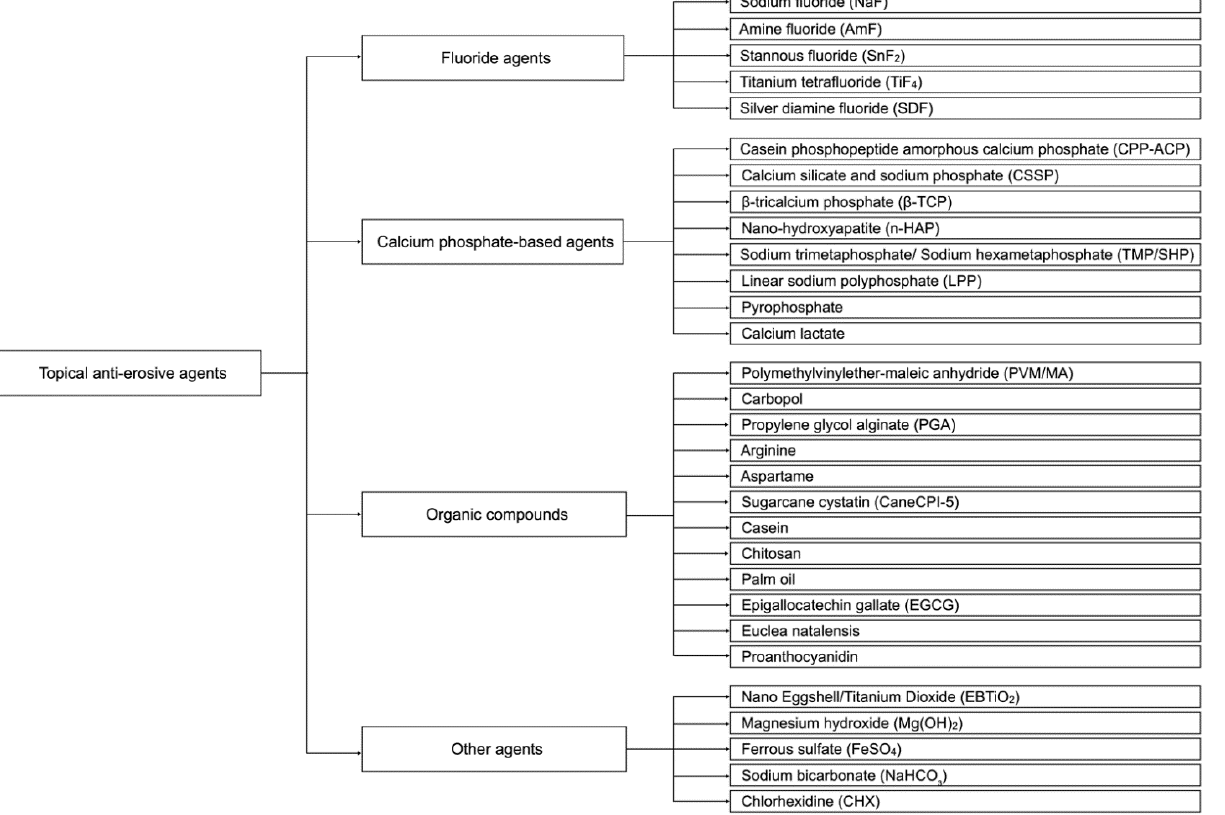
Figure 2. Topical anti-erosive agents.